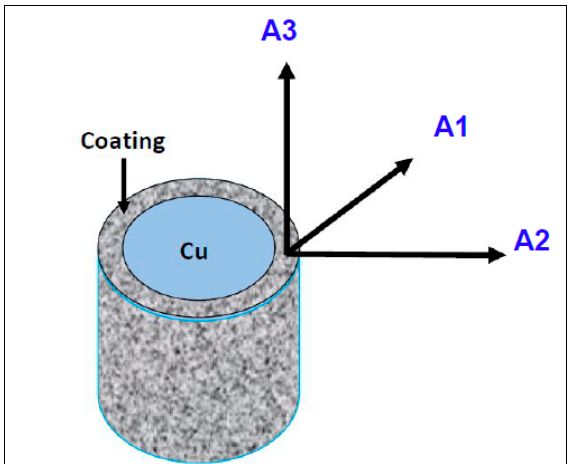
Figure 2. Schematic illustration of the transverse cross section of samples with the coordinate system.